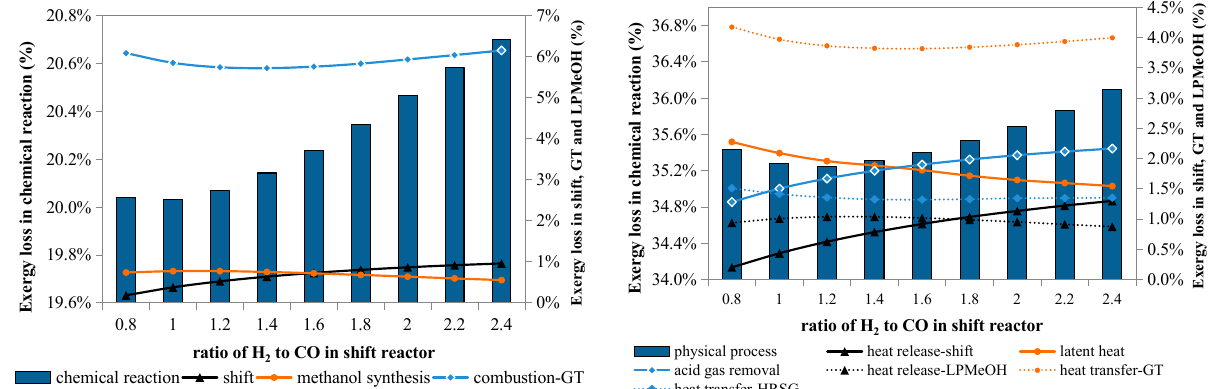
Figure 7. Exergy loss in a partial shift polygeneration system.